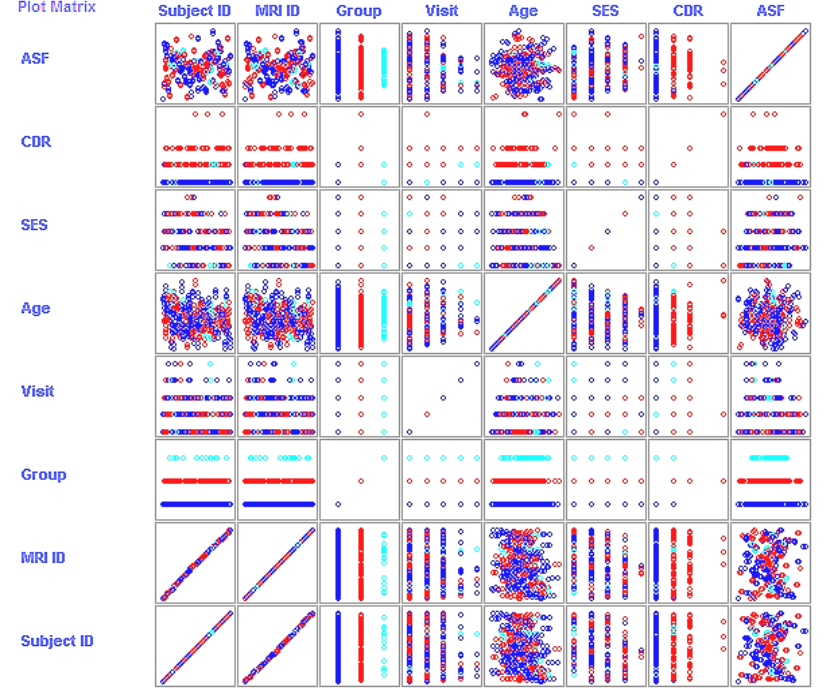
Figure 2. Scatter plot of selective features. Blue dots (ND), red dots (D), light blue dots (C).